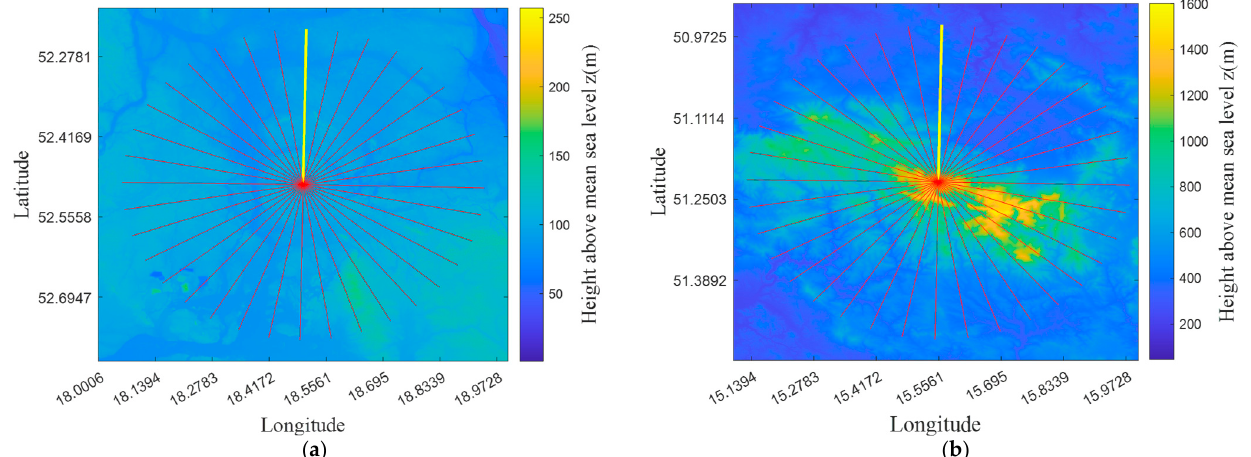
Figure 3. DTED-based elevation maps for two selected TX locations in ( a ) lowland and ( b ) hilly areas for which terrain profiles are calculated.